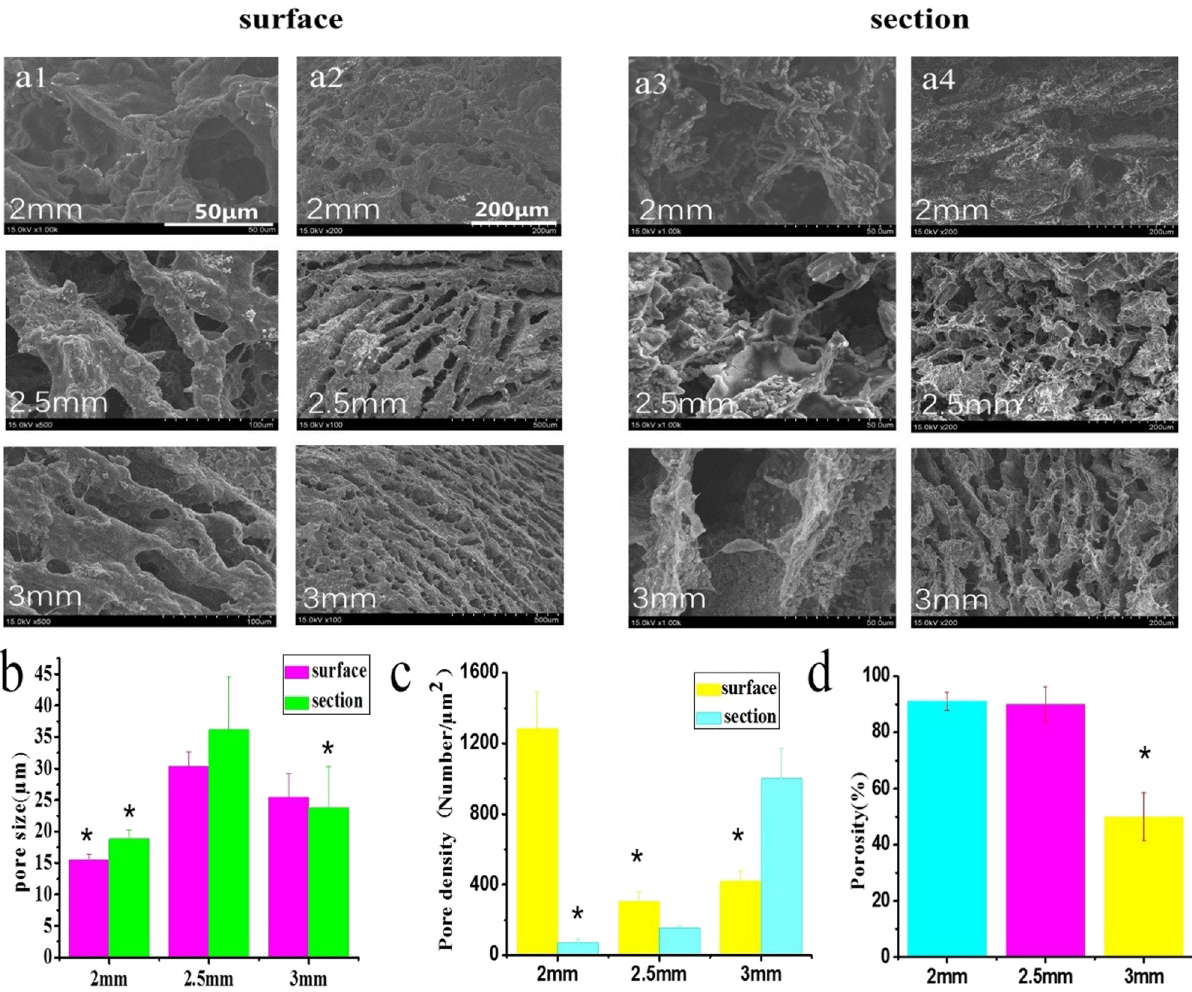
Figure 3: Morphological characterization of GG/ST sca ff old. ( a ) Cross - sectional view of the sca ff olds taken by scanning electron micro - scope; ( b ) quantitative analysis of the cross - sectional pore size; ( c ) quantitative analysis of the cross - sectional pore density; ( d ) porosity test. * p < 0.05 by one - way ANOVA test.